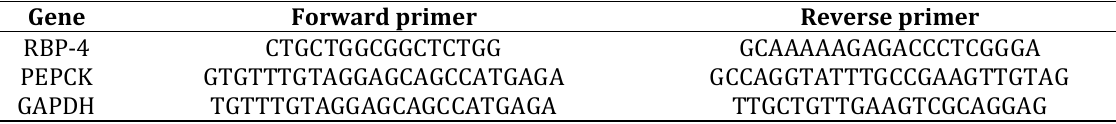
Table I. Primer sequences for the quantitative PCR Gene Forward